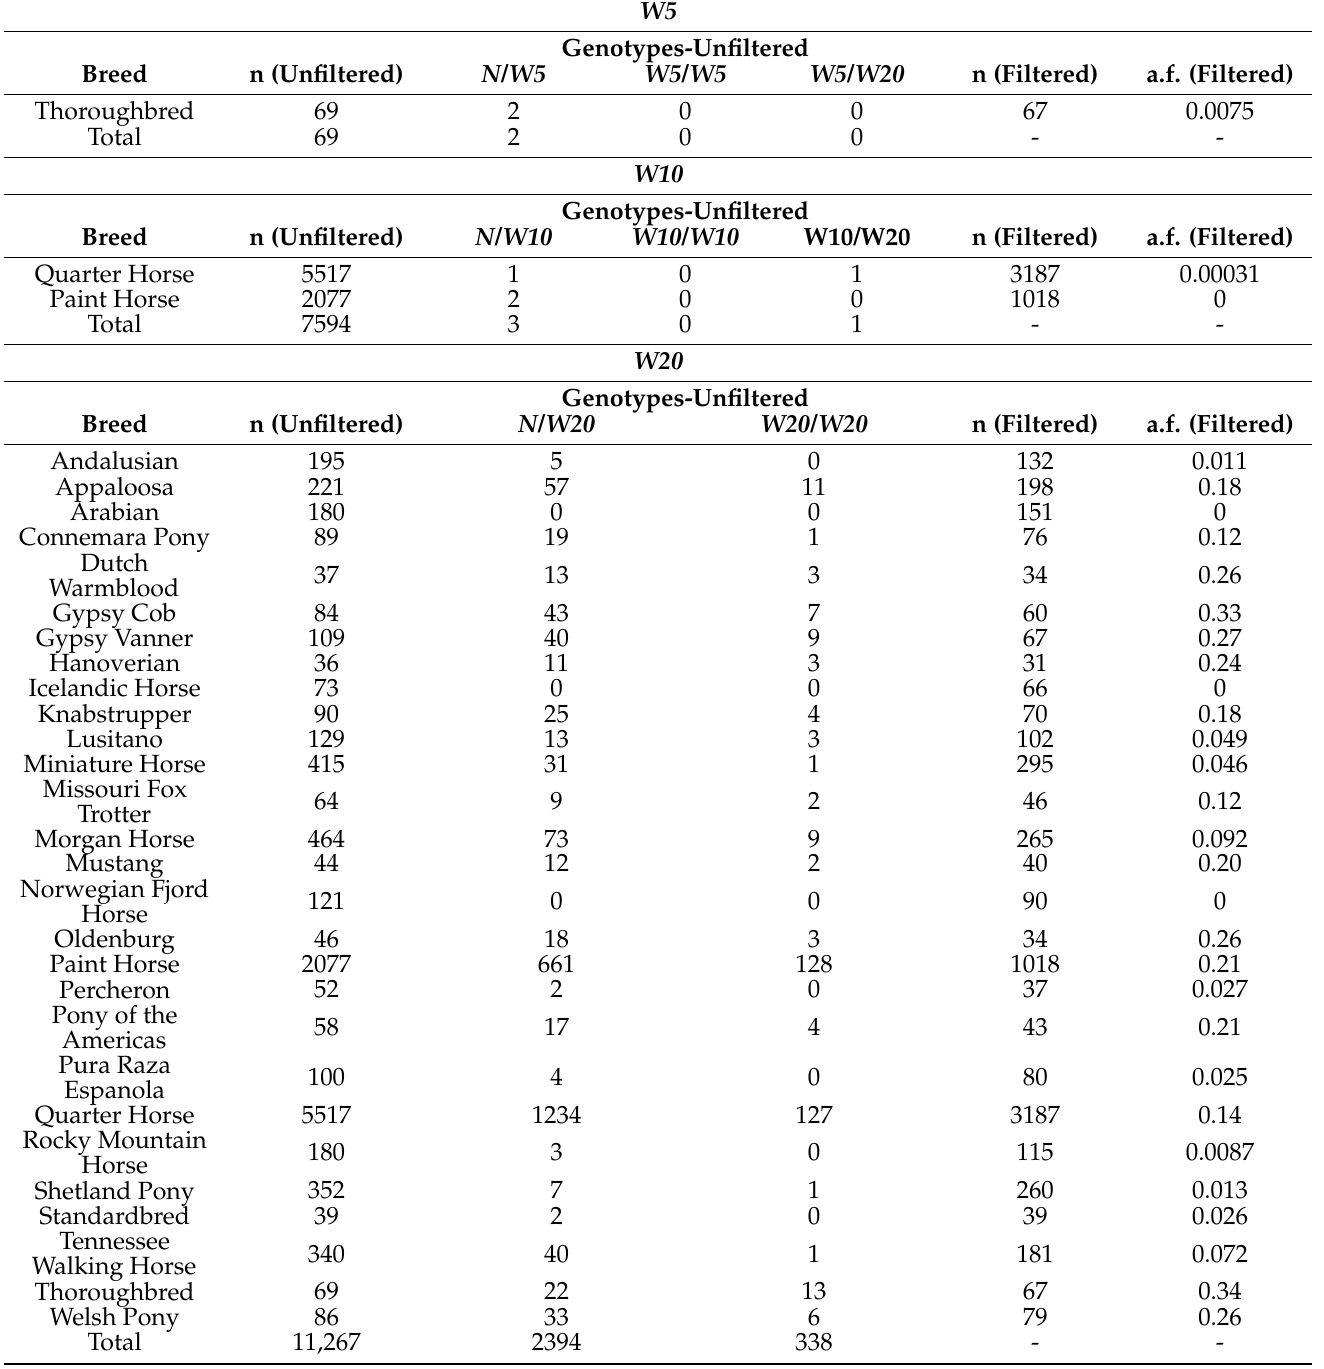
Table 2. Number of individuals tested (n), number of heterozygous and homozygous, and estimated allele frequencies (a.f.) after filtering for relatedness for dominant white variants W5 , W10 , W20 , and W22